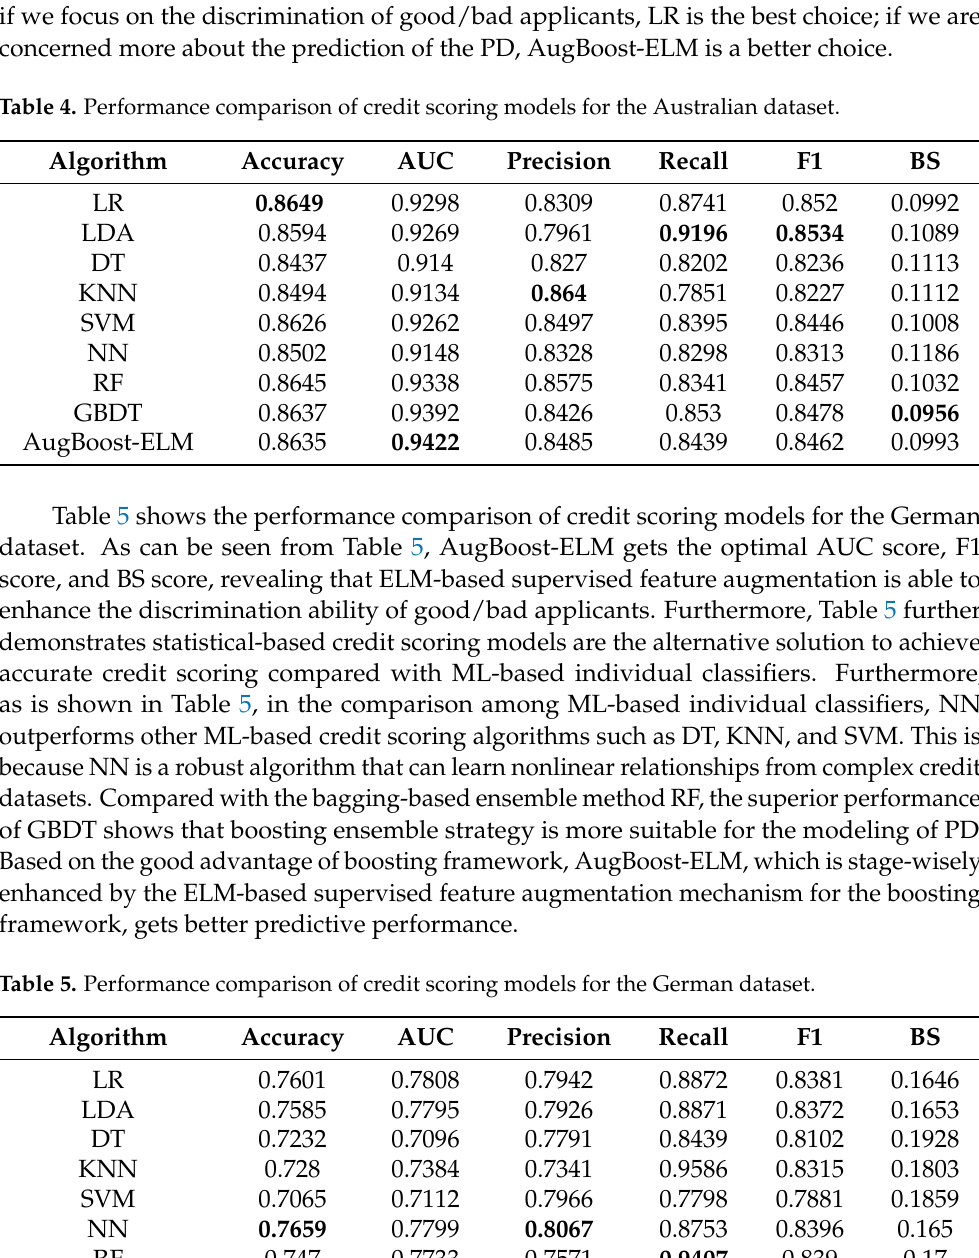
Table 6 is the performance comparison of credit scoring models for the Japanese